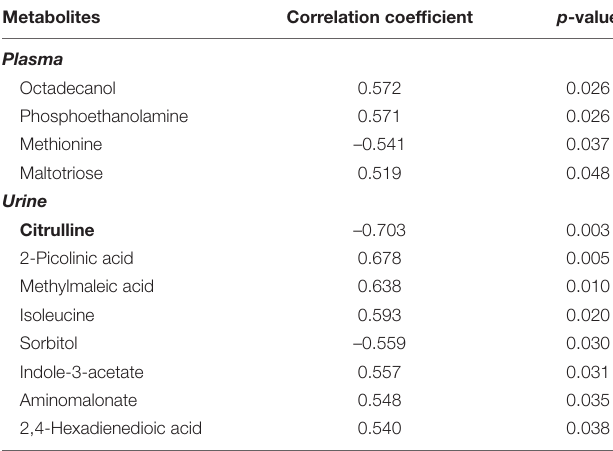
TABLE 3 | Metabolites with change in abundance significantly associated with change in RSS.